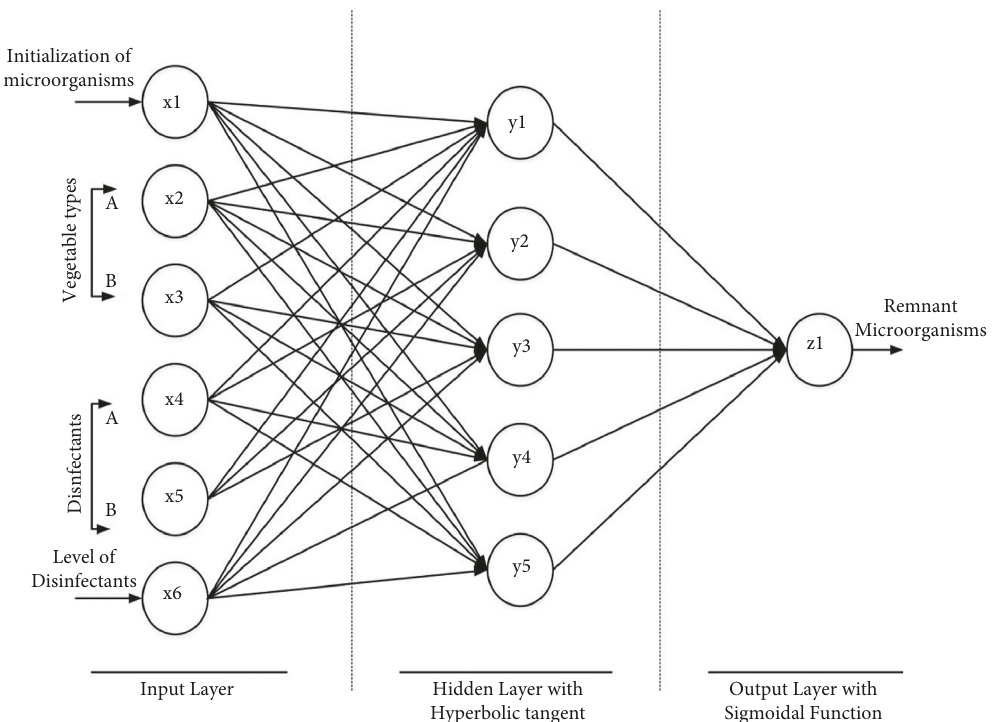
Figure 5: Outline of ANN framework for the prediction of remnant E. coli on lettuce and